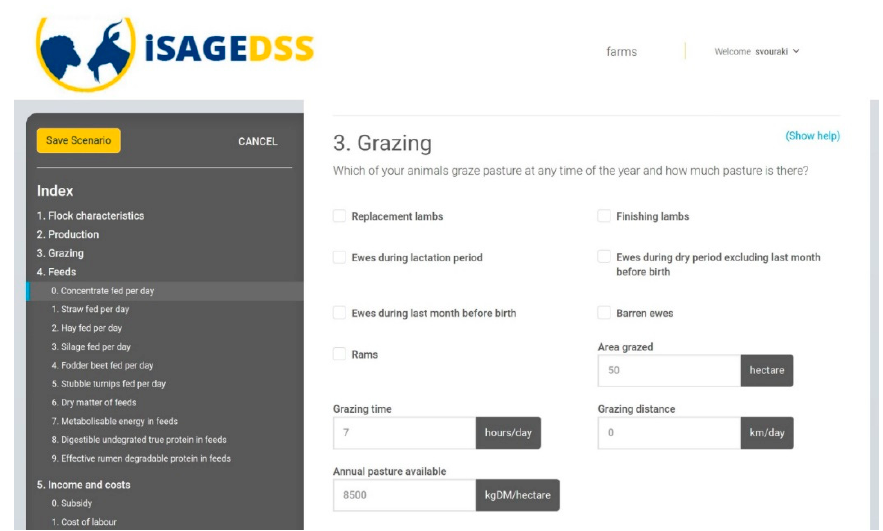
Figure 5. Grazing section of the input parameters page; users input whether their animals will be grazing or not and provide relevant information for grazing.